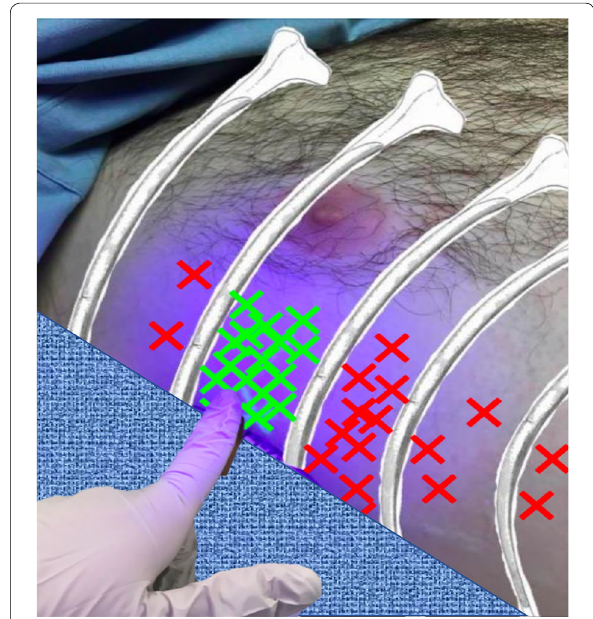
Fig. 3 This is an illustrative representation of the data plotted on the volunteer’s chest wall for the landmark-palpated method. The green “X’s” represent the correct intercostal space, whereas the red “X’s” demonstrate the number of participants who did not place the marker in the correct ICS. The data plotted were illustrated and represented in rib spaces above and below the target